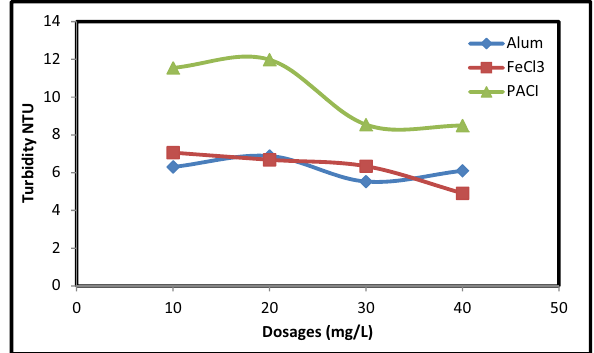
Figure 16: The relation between coagulants and fi nal residual tur - bidity for samples at 240 cm.